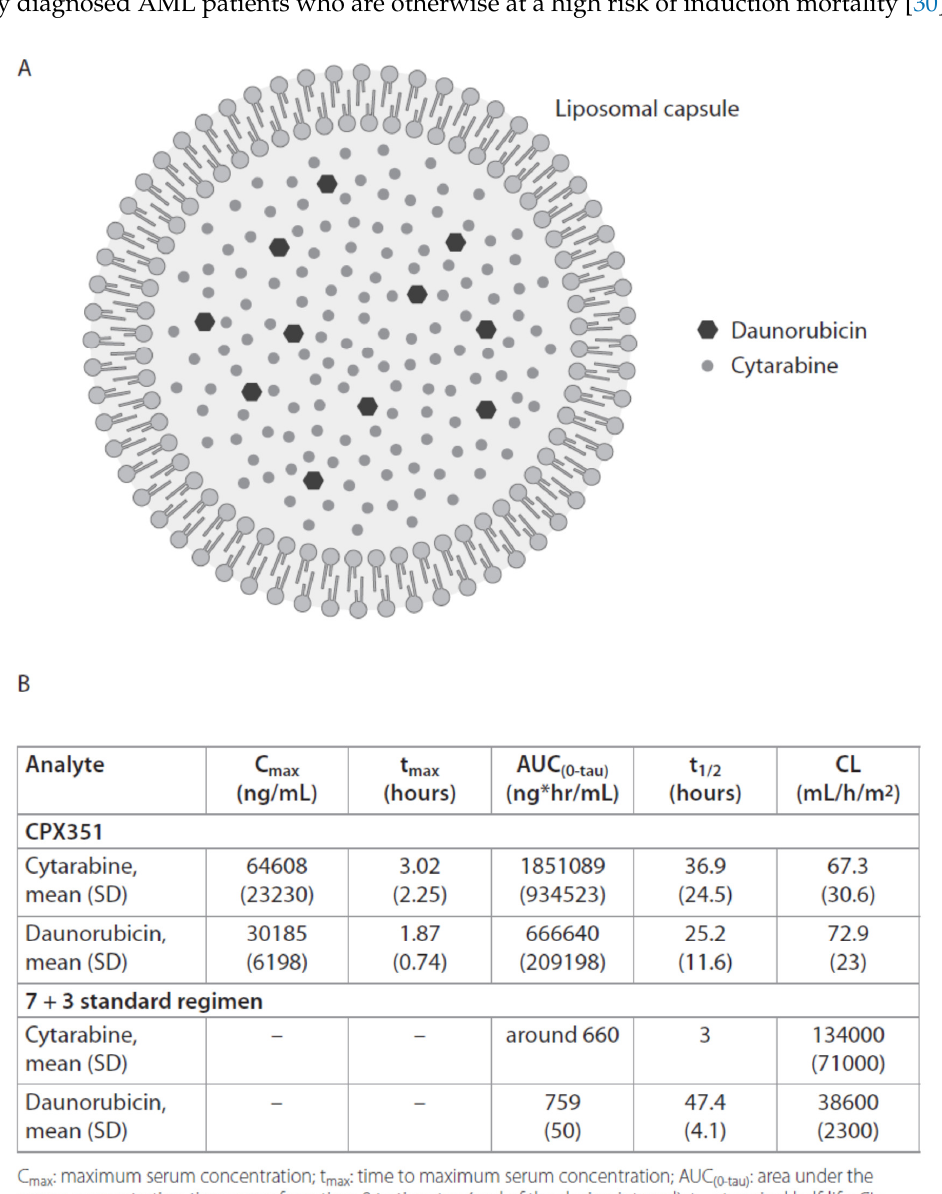
Figure 1. Schematic representation and pharmacokinetics of CPX-351. ( A ) CPX-351 is a liposomal formulation of the cytotoxic drugs cytarabine and daunorubicin at a molar ratio of 1:5; ( B ) A comparison between the pharmacokinetic features of liposomal cytarabine and daunorubicin (on day 5 after infusion of CPX-351 (101 units/m 2 ) [24]) versus non-liposomal forms [25–27]. 4. FLT3 Inhibitors Mutations in the FMS-like tyrosine kinase 3 (FLT3), which is a receptor tyrosine kinase involved in the proliferation, differentiation, and apoptosis of hematopoietic cells (Figure 2) [32], are the most frequent genetic lesions in AML, occurring in around one-third of patients [33]. Two different types of FLT3 mutations have been detected in malignant cells from AML patients: internal tandem